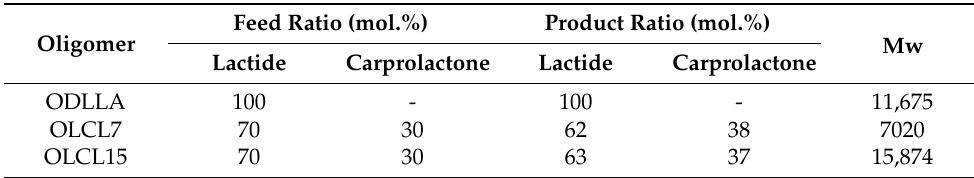
Table 1. Characteristics of oligomers.